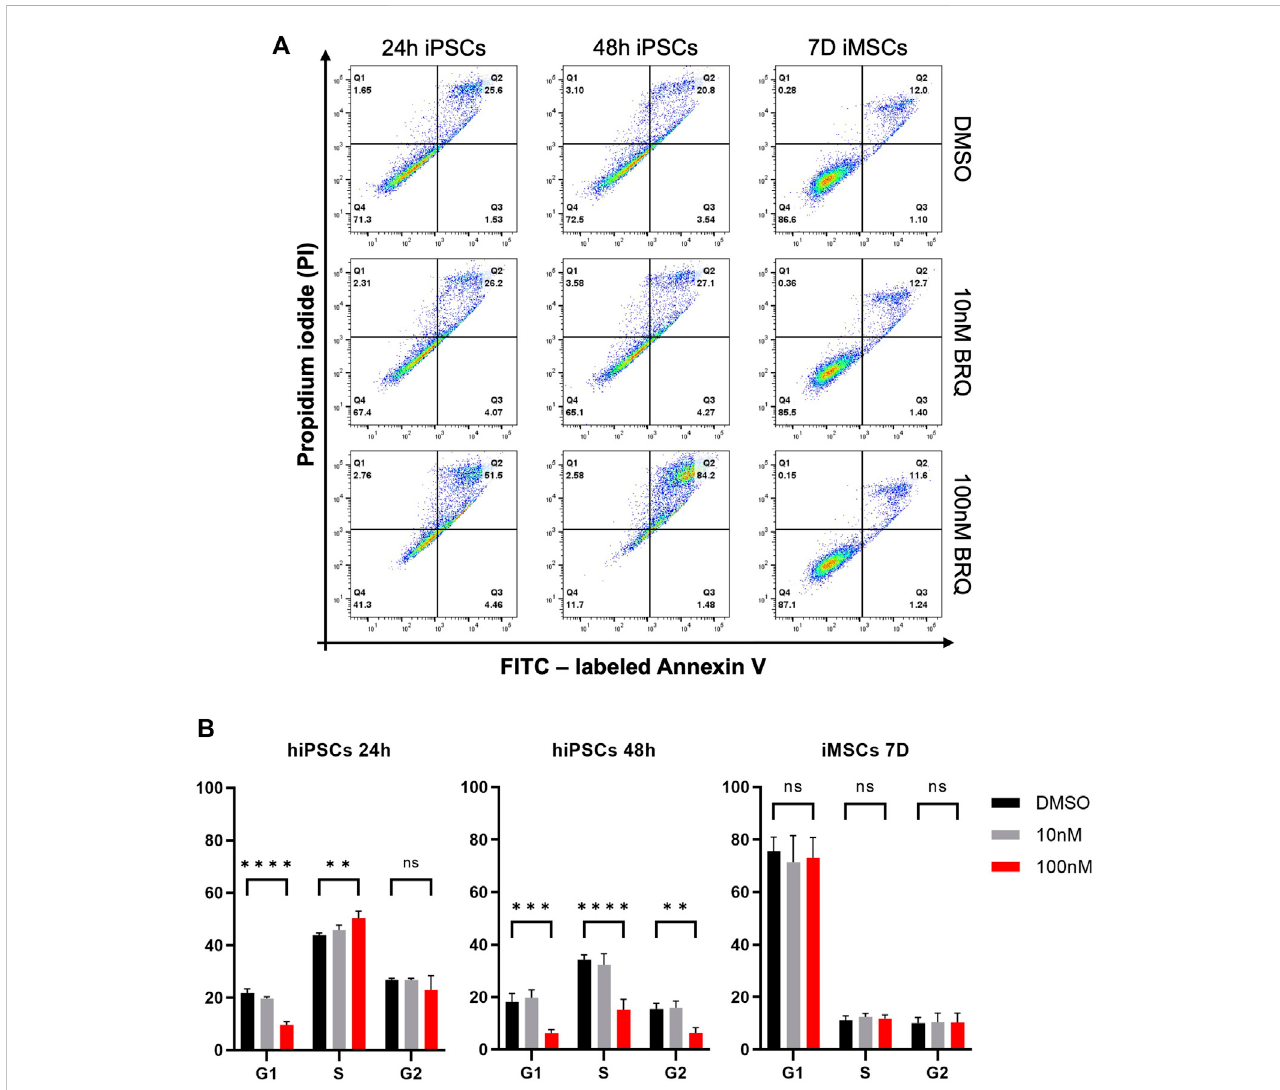
FIGURE 4 Induction of apoptosis and cell cycle arrest in hiPSCs but not in iMSCs by BRQ treatment. hiPSCs were cultured until 70% con fl uence was reached, and iMSCs were treated directly after plating for 7 days. (A) Apoptosis detection in 24 h and 48 h BRQ- and DMSO-treated hiPSCs and 7 days BRQ and DMSO- treated iMSCs. Dissociated cells were collected in cell suspension, stained with FITC labeled Annexin V and propidium iodide (PI) using an Annexin Apoptosis DetectionKit,andanalyzedby fl owcytometry.n=3,representative fi gures. (B) Cellcycleanalysisof24 hand48